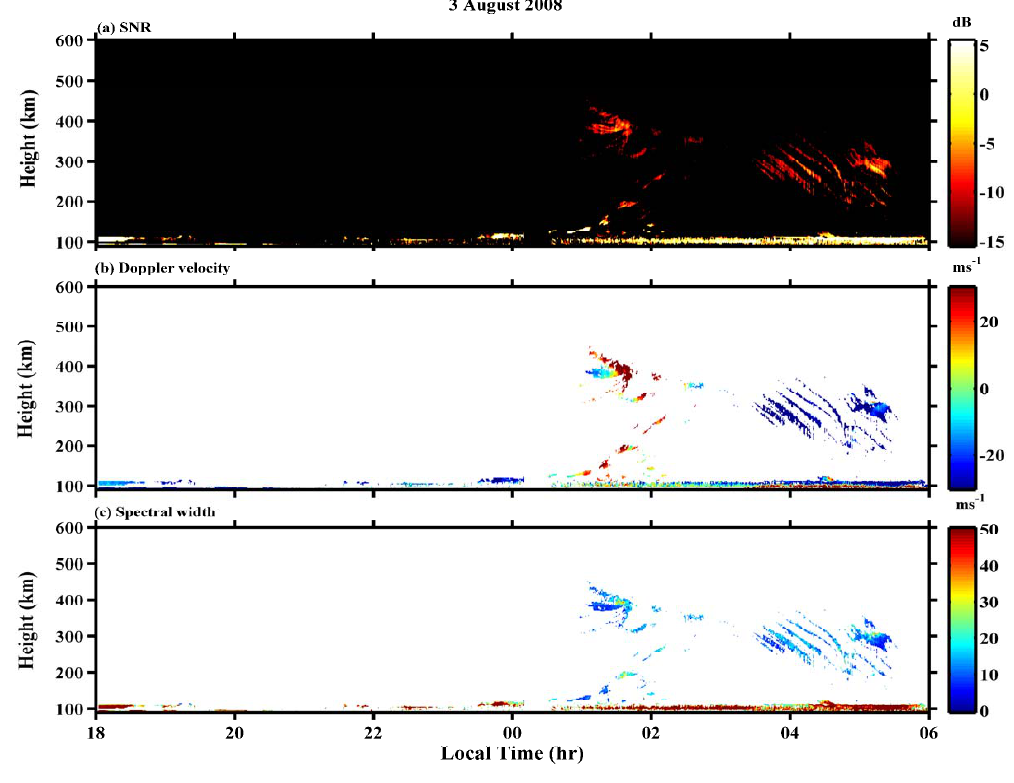
Fig. 4. Same as Fig. 3, but for 3 August